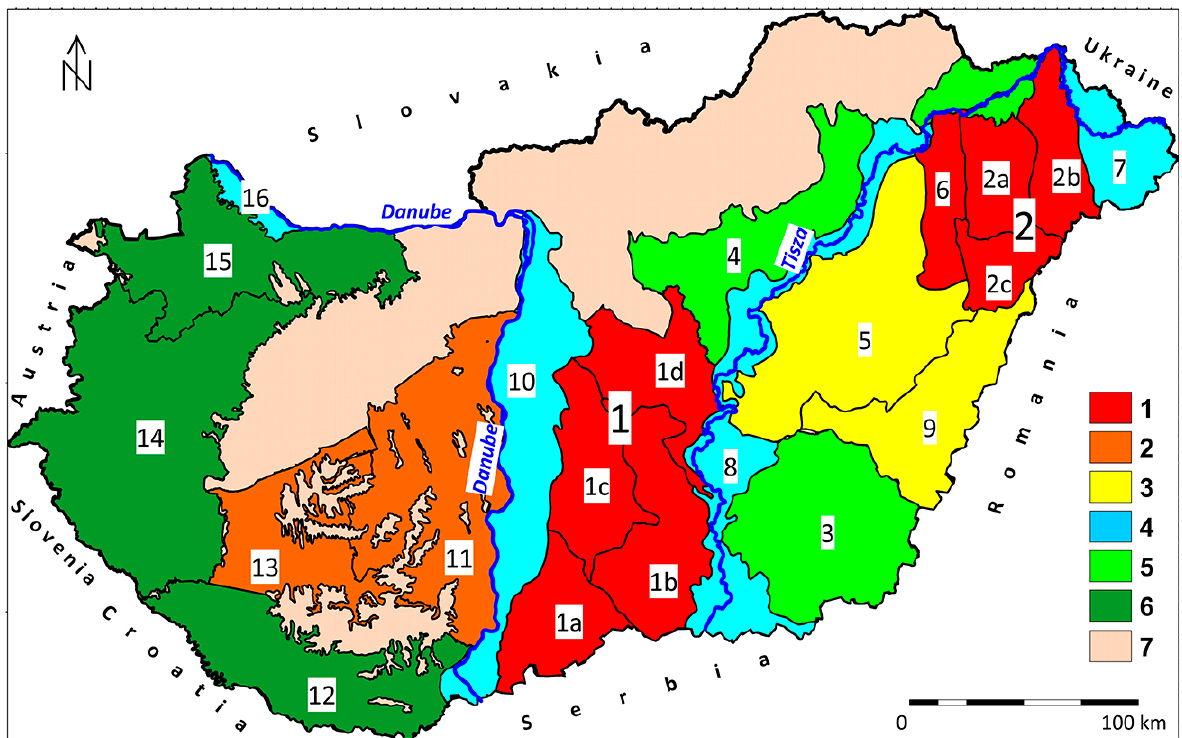
Figure 12. Climate sensitivity of Hungarian landscapes based on their water balance